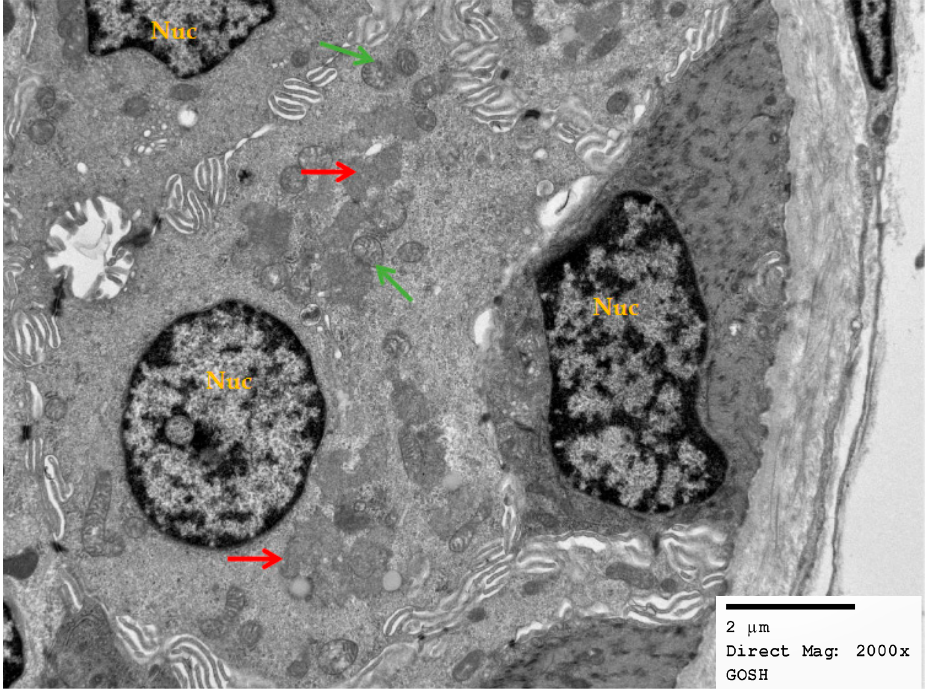
Figure 4. Low-power electron micrograph, mag. × 2000, of secretory epithelial cells from an eccrine sweat gland with abnormal storage inclusions present in clusters of expanded lysosomes (red arrow). Numerous mitochondria with normal morphology present (green arrow) and prominent nuclei (Nuc) also with normal appearances.